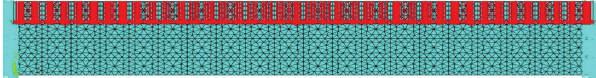
Figure 5: Applied uniformly distributed load on the top longitudi- nalsurfaceandfixedboundaryconditiononthetwoendsofatypical porous beam model.